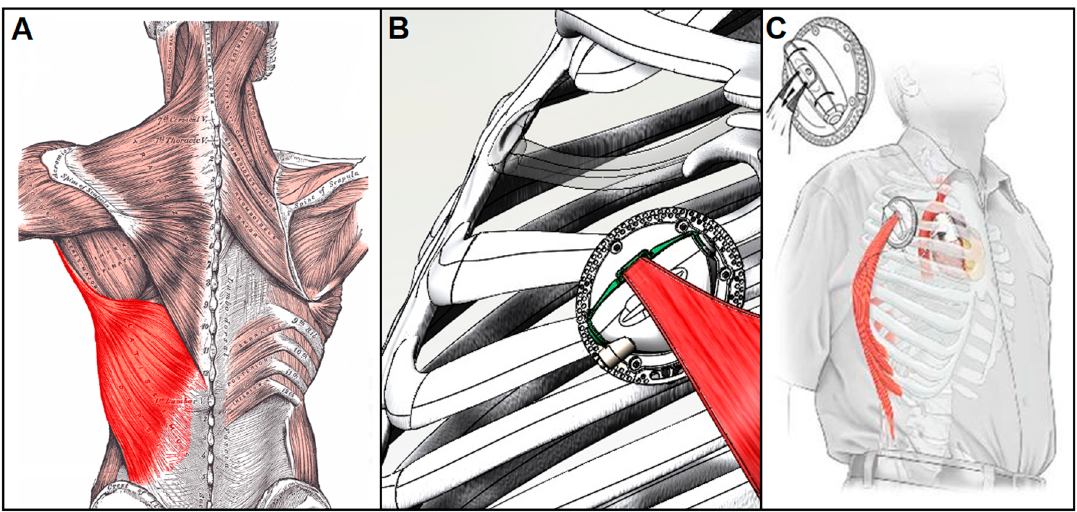
Figure 7. Muscle-powered VADs could use the latissimus dorsi ( A ) as its power source and convert this endogenous muscular power into hydraulic energy via a completely implantable muscle energy converter ( B ) that can potentially power pulsatile VADs for long-term use ( C ) [103,106,107].